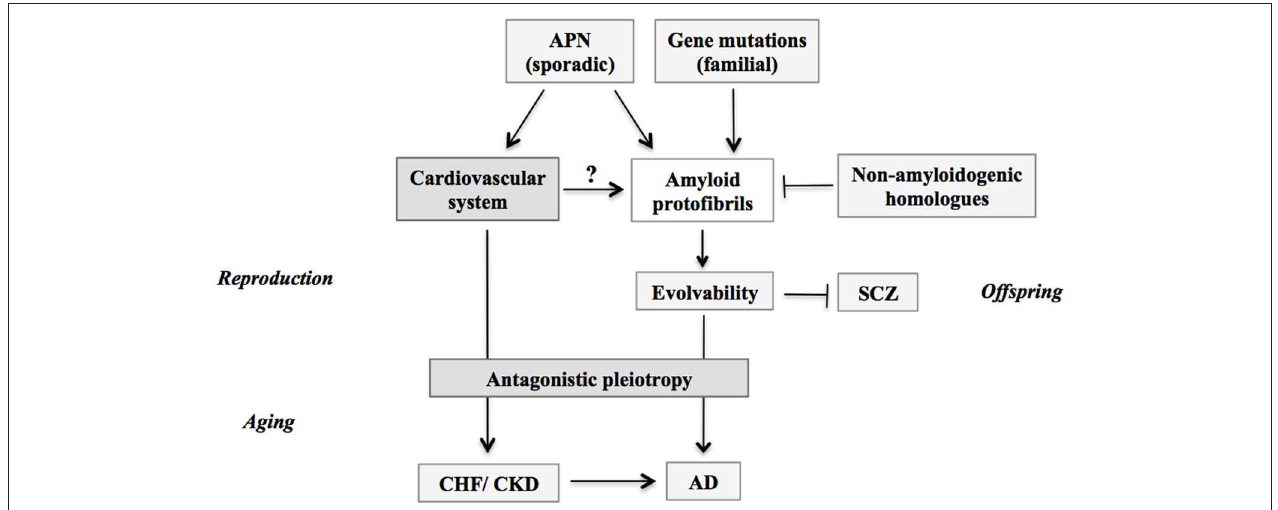
FIGURE 2 | Schematic; stimulation of evolvability by APN and manifestation as diseases. APs protofibrils might be involved in the stress resistance, namely hormesis, in parental brain. Furthermore, by virtue of the information carried by the transmission of APs protofibrils in reproduction, offspring can cope with the forth-coming stresses in the brain to escape from neurodevelopmental diseases such as schizophrenia. Thus, the APs protofibrils may confer evolvability which is evolutionally beneficial. However, the evolvability of APs protofibrils may increase the risk of AD through the antagonistic pleiotropy. Amyloid protofibrils/evolvability may be stimulated by missense mutations of genes in familial AD, and by APN in sporadic AD, but suppressed by non-amyloidogenic homologous proteins such as β -synuclein. Given the effects of CHF and CKD to increase the risk of AD in aging, these phenomena might be attributed to the stimulatory effect of APN on amyloidogenic evolvability through cardiovascular system in the reproductive stages. APN, adiponectin; CHF, chronic heart failure; CKD, chronic kidney disease; AD, Alzheimer’s disease; SCZ,